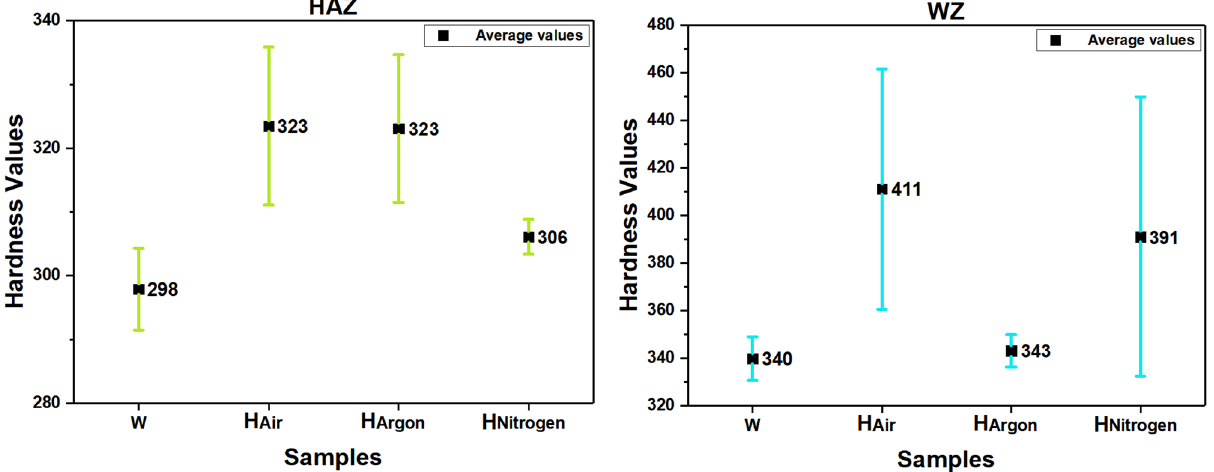
Figure 20. Average values of hardness of weld zone and heat affected zone.